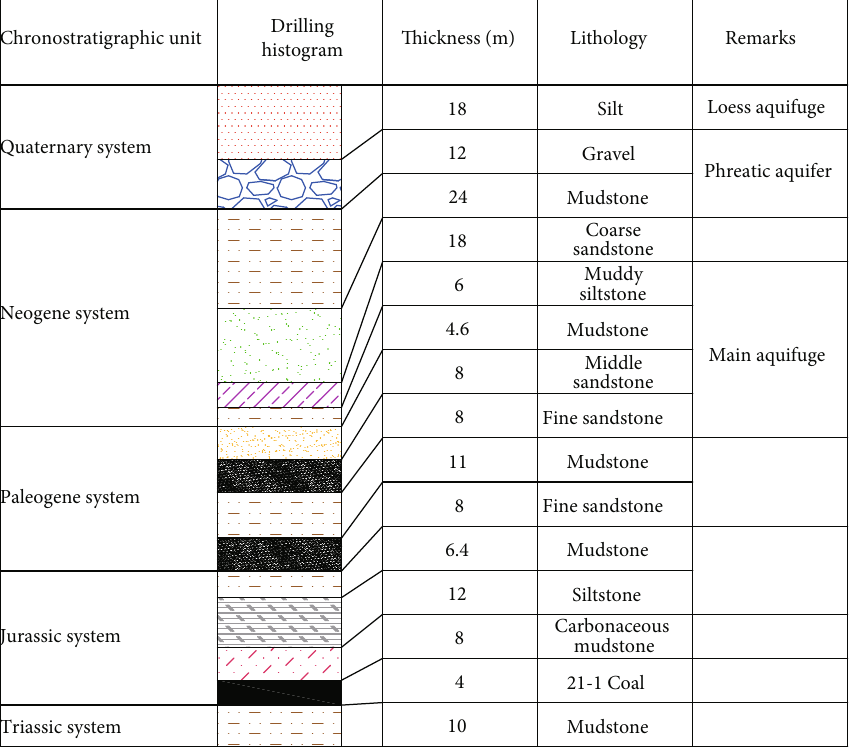
Figure 2: Borehole histogram.